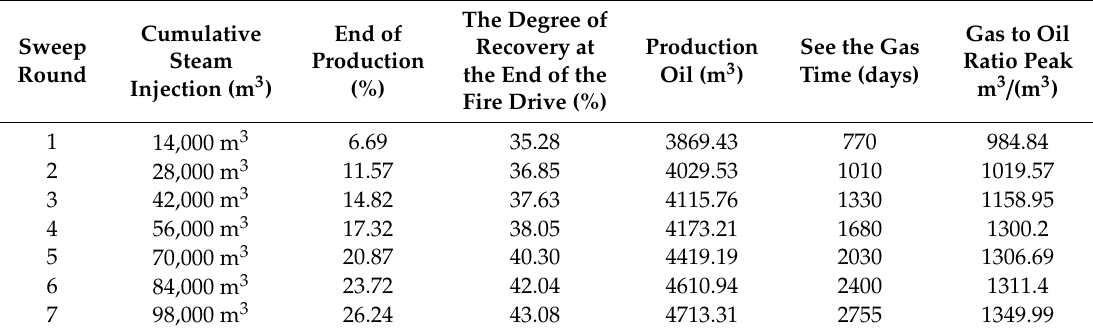
Figure 2. Comparison of the production indicators under di ff erent hu ff and pu ff rounds. ( a ) Recovery degree; ( b ) cumulative oil production; ( c ) gas-oil ratio; and ( d ) gas production rate. Table 2. Dynamic production indicators under di ff erent hu ff and pu ff (HP) rounds.